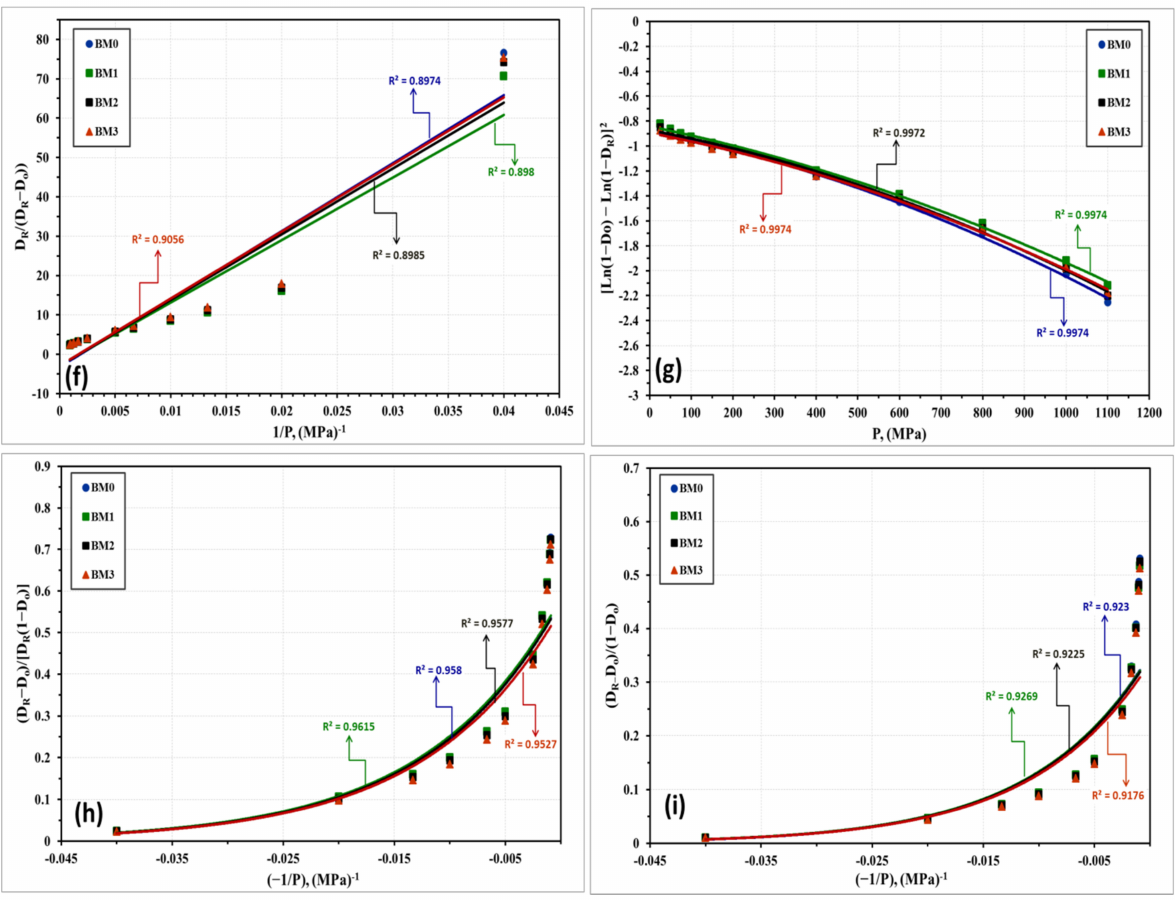
Figure 10. Compressibility results of the as-milled BM0, BM1, BM2, and BM3 alloy samples obtained from: ( a ) compressibility experiments conducted on these alloys. ( b – i ) are the compressibility results obtained empirically from applying models (1) through (8),